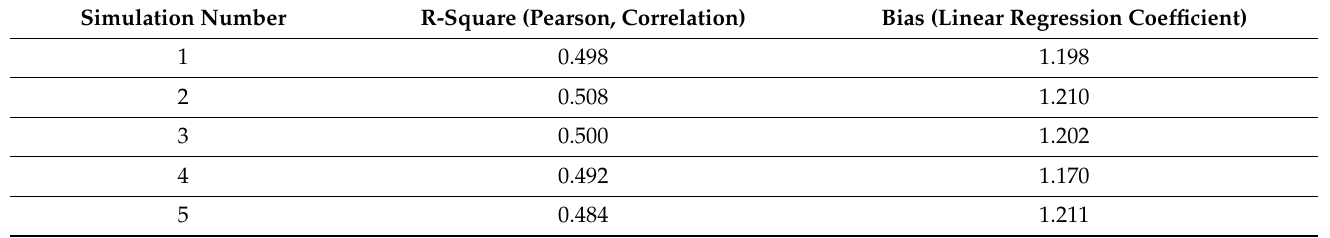
Table 3. Results of Monte Carlo Simulations—random pairing of AUC 24 to MIC to calculate AUC 24 :MIC (see text for